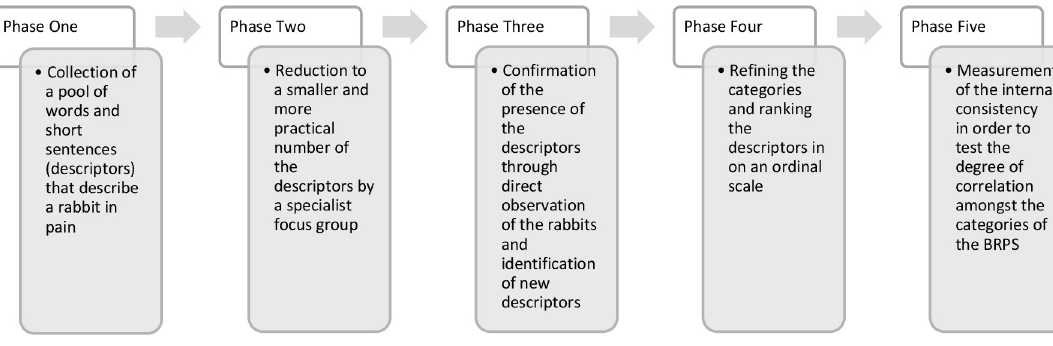
Fig 1. Overview of the BRPS